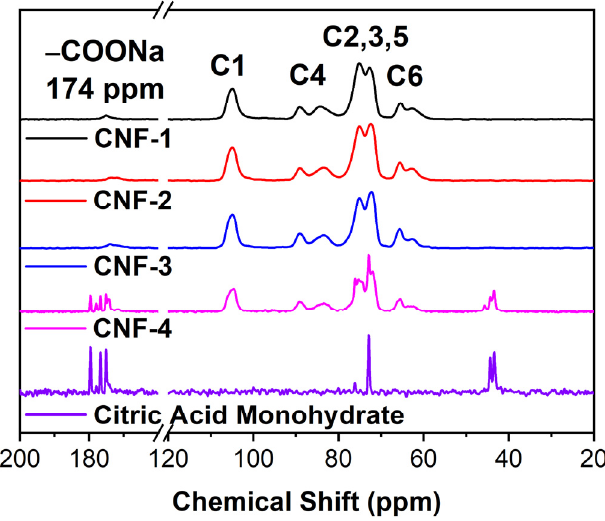
Figure 1. 13 C CPMAS NMR spectra of all CNF membranes and the citric acid monohydrate.